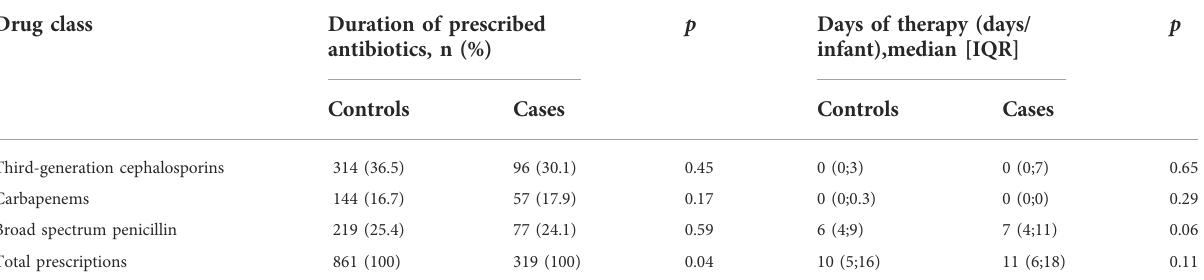
TABLE 3 The usage of BSAs usage in case and control group.